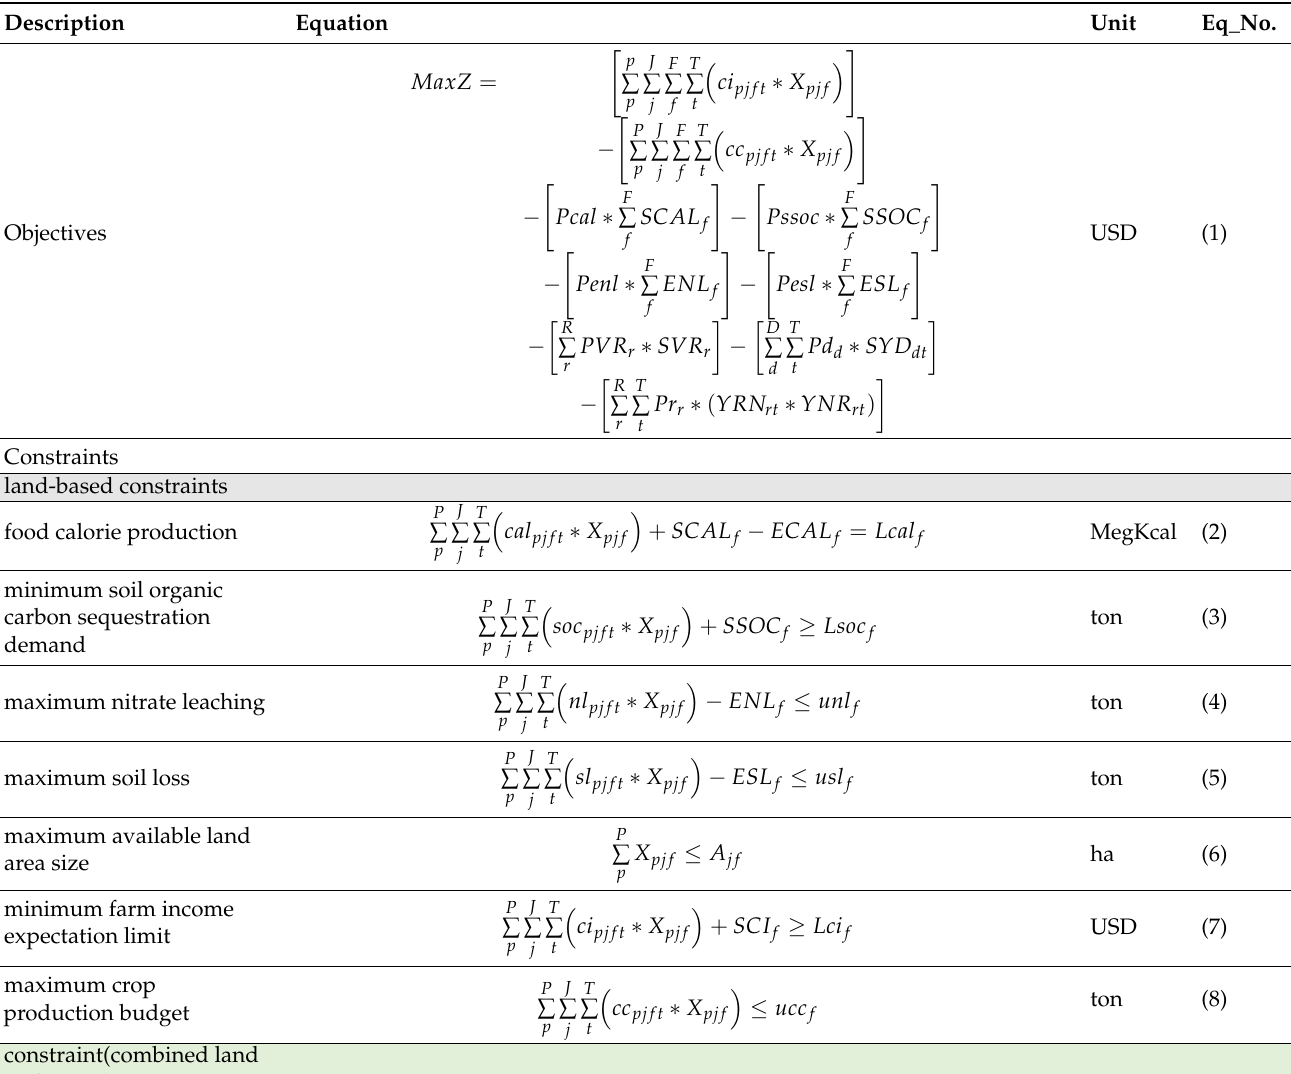
Table 1. Objective and constraint function used in the